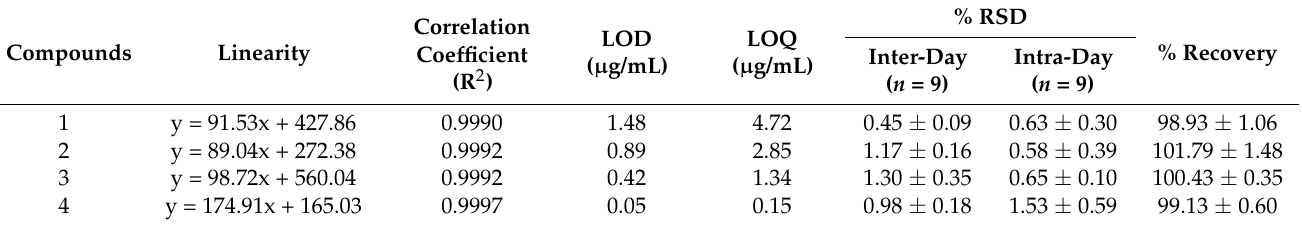
Table 2. Validation of HPLC analysis of marker compounds of CA ( 1 – 3 ) and CC ( 4